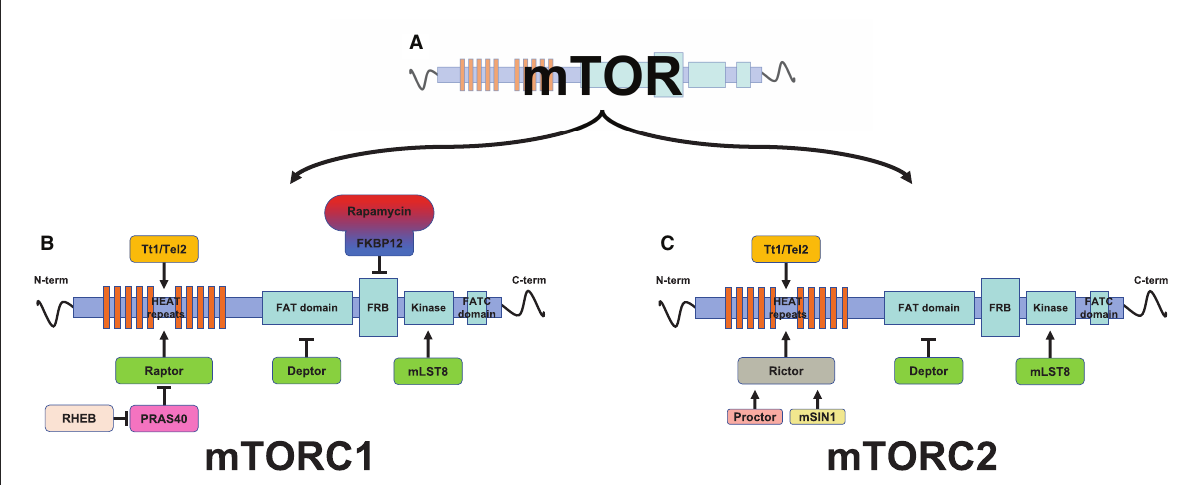
FIGURE2 Schematic representation of mammalian target of rapamycin (mTOR) protein complexes. The mTOR protein (A) is associated with other proteins to form two distinct multiprotein complexes, mTOR complex 1 (mTORC1) (B) and mTORC2 (C) . mTOR is a multidomain protein kinase. From the N-terminus, the first domain of the mTOR protein is formed by a HEAT repeat (tandem-repeat protein domains) domain, which functions as protein-protein interaction surfaces for the substrate’s recruitment proteins, Raptor (regulatory-associated protein of TOR, which define mTOR complex 1, mTORC1) and Rictor (rapamycin-insensitive companion of TOR, which define mTOR complex 2, mTORC2). Proctor (protein observed with Rictor) and mSin1 (mammalian stress activated protein kinase interacting protein 1) act as a Rictor activator. HEAT repeats further interaction with the Tt1/Tel2 complex (Tt1, Tel two interacting protein 1; Tel2, telomere maintenance 2, also described as HCLK2), thus stabilizing the mTOR protein. The Tt1/Tel2 complex (Tt1, Tel two interacting protein 1; Tel2, telomere maintenance 2, also described as HCLK2) interacts with the HEAT repeats, thus stabilizing mTOR. The FAT (FRAP, ATM, TRRAP) domain is the binding site for the mTOR inhibitor Deptor (the DEP domain containing a mTOR-interacting protein). The FRB (FKBP–rapamycin-binding) domain, which precedes the kinase domain, interacts with the inhibitory rapamycin via the immunophilin FKBP-12 (FK506-binding protein 12 kD). The mTOR kinase domain resides between the FRB and focal adhesion targeting C-terminal (FATC) domains, and shares a characteristic of both PI3K and canonical protein kinase families. Its kinase activity is enhanced by mLST8 (mammalian lethal with SEC13 protein 8). The latter domain of the mTOR protein is the FATC (FAT C-terminus) domain, located at the C-terminus of the